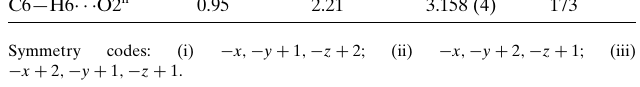
Table 2 Experimental